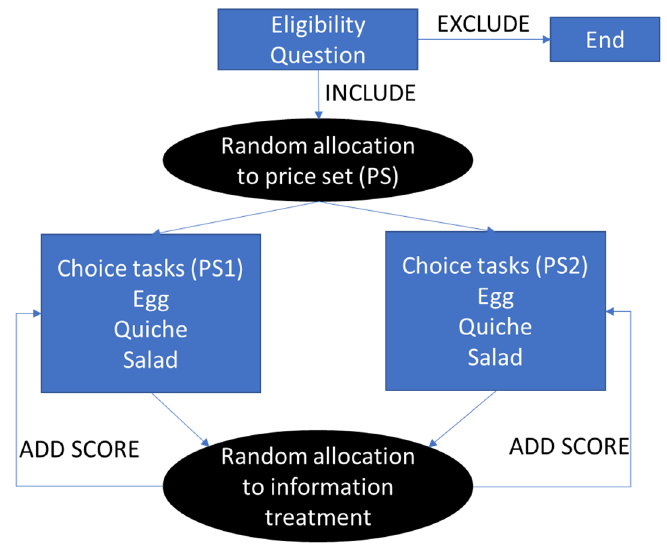
Figure 2. Experimental design illustrating the survey structure.